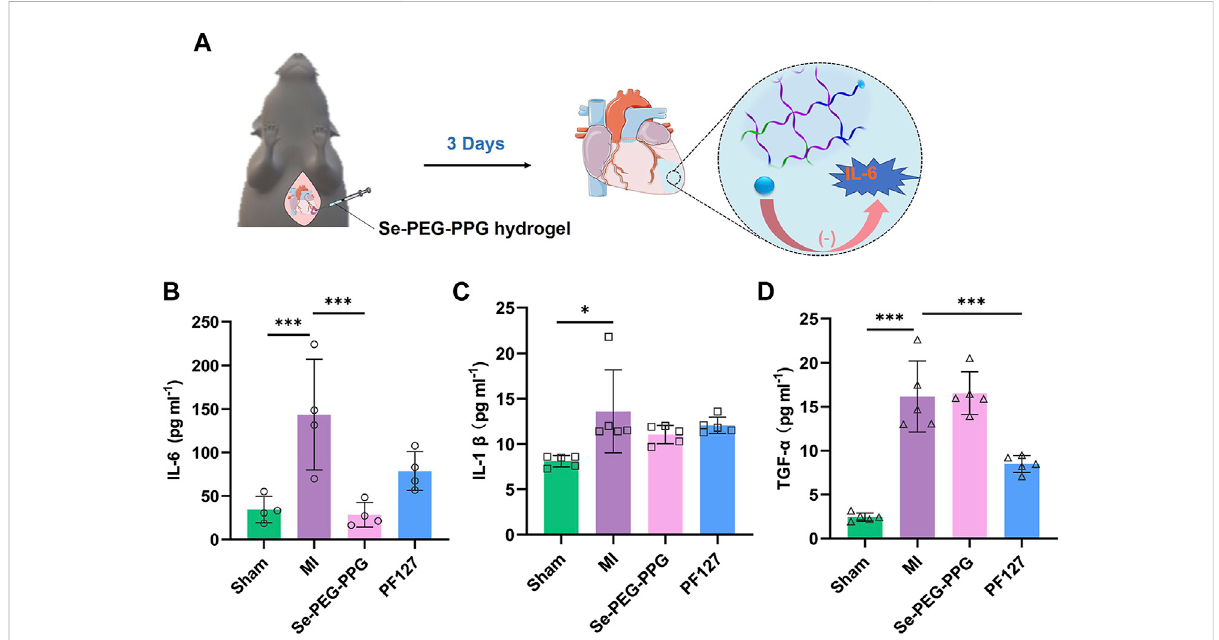
FIGURE 5 Expression of in fl ammatory cytokines in serum on the third day after MI. (A) Diagrammatic sketch of downregulation of IL-6 expression after intramyocardialinjectionwithSe-PEG-PPGhydrogel; (B) Expression levelofIL-6( n =4,*** p < 0.01); (C) Expression levelofIL-1 β ( n =5,*** p < 0.01); (D) Expression level of TNF- α ( n = 5, *** p <